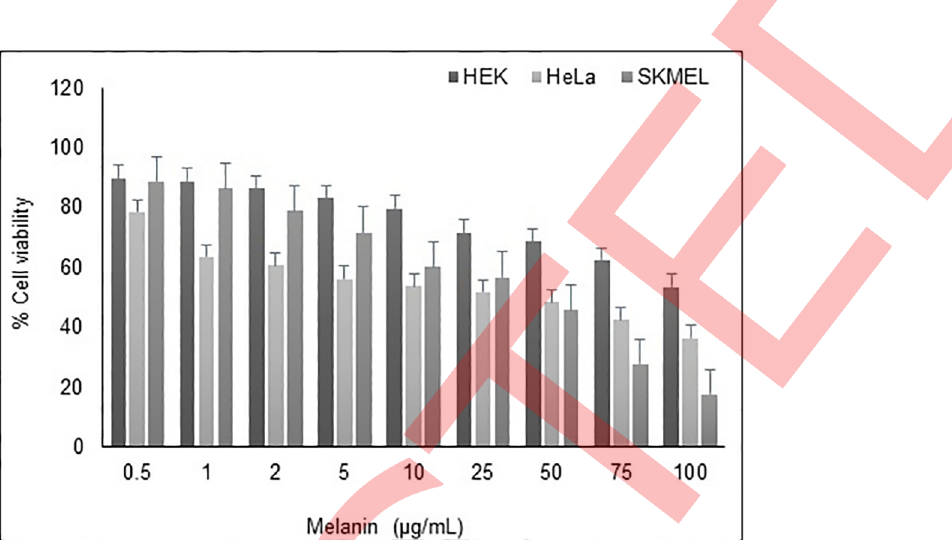
Fig 5. Cell viability assays of HEK 293, HeLa, and SK-MEL-28 cell lines were tested for 24 h with various concentrations ranging from 0.5 to 100 μ g/mL in 96 well plates. The cell viability was determined at maximum absorption at 570 nm. A graph was depicted with melanin concentrations on the x-axis and percent viable cells on the y-axis.